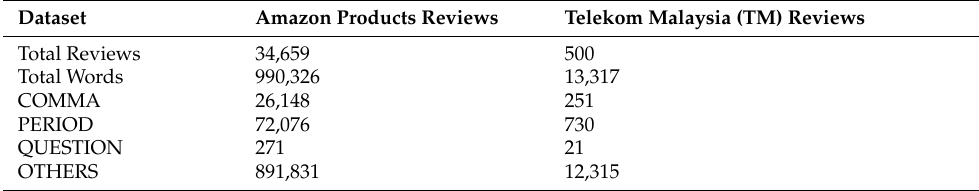
Table 5. Possible punctuation placement to produce more sentiment